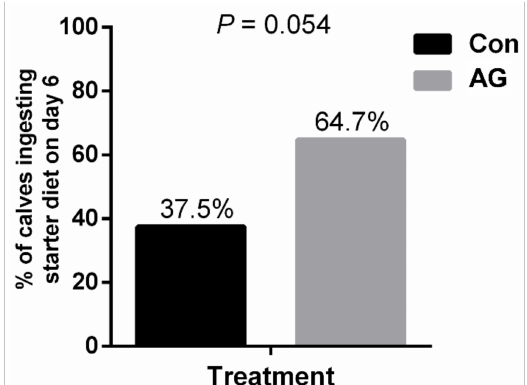
Figure 3. The e ff ect of artificial grooming on the percentage of Holstein female calves ingesting starter diet on day 6. E ff ect direction is provided when the mean e ff ect is p ≤ 0.10. Data are presented as